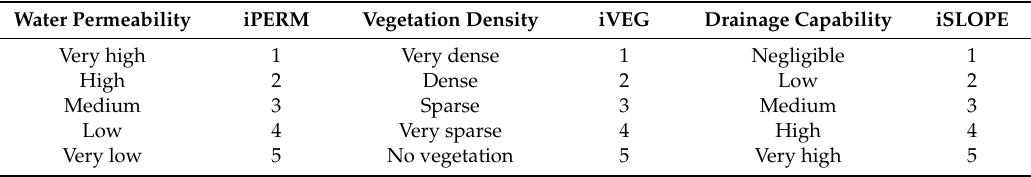
Table 1. Coding of geomorphology characteristics for estimation of the reference value of the CN parameter (CNII,20). Note: iPERM represents water permeability; iVEG represents land uses; iSLOPE represents drainage capability.